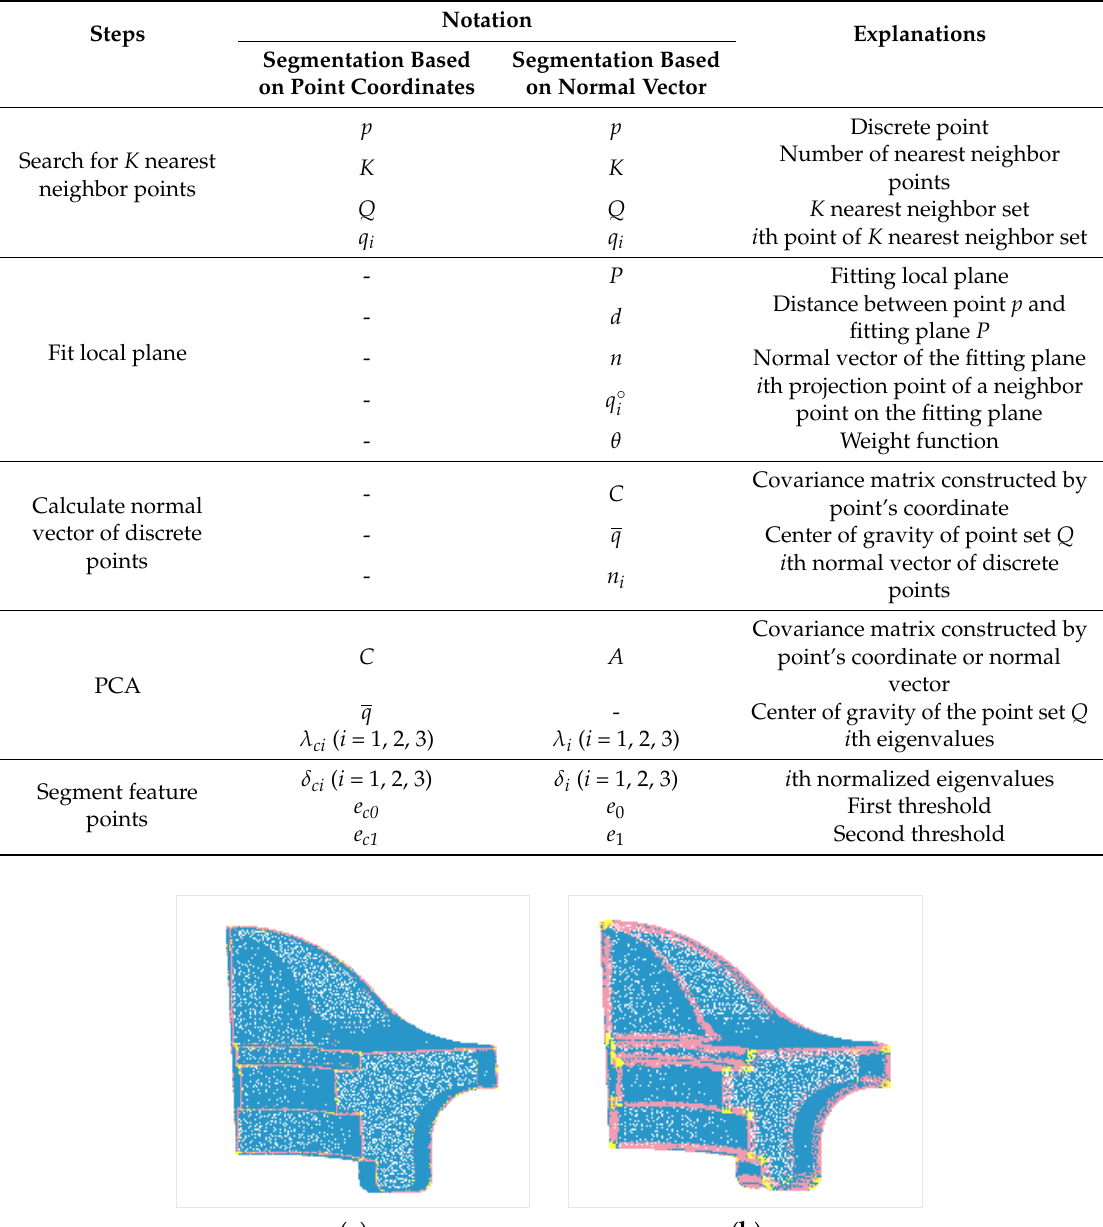
Table 1. Steps, notation, and explanations for feature point segmentation based on points’ coordinates and normal vectors.